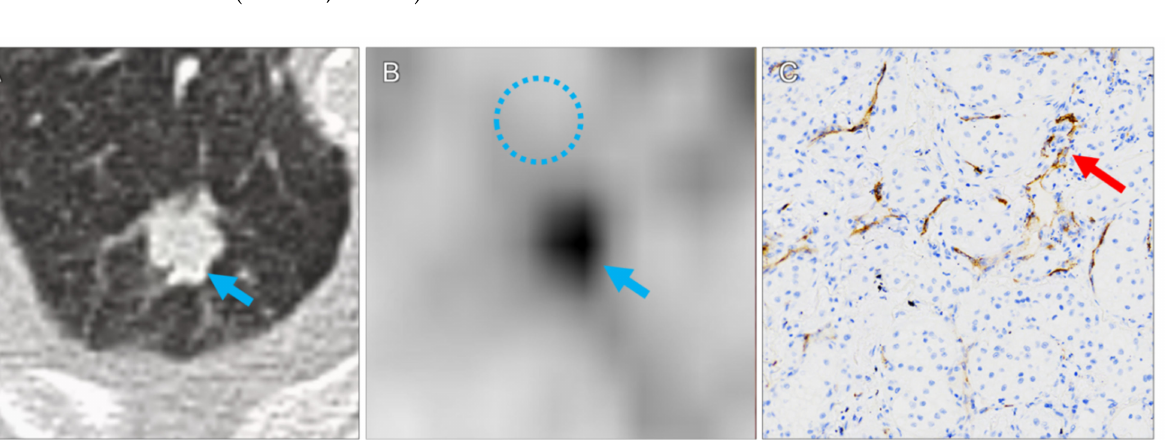
Figure 2. Pulmonary metastasis in the right upper lobe (( A ), arrow; lesion 6). Due to the low background activity in the lung (( B ), circle, SUVmax 0.9) the moderate tracer uptake in the tumor is clearly visible (( B ), arrow, SUVmax 4.2). Moderate microvascular PSMA expression (( C ),